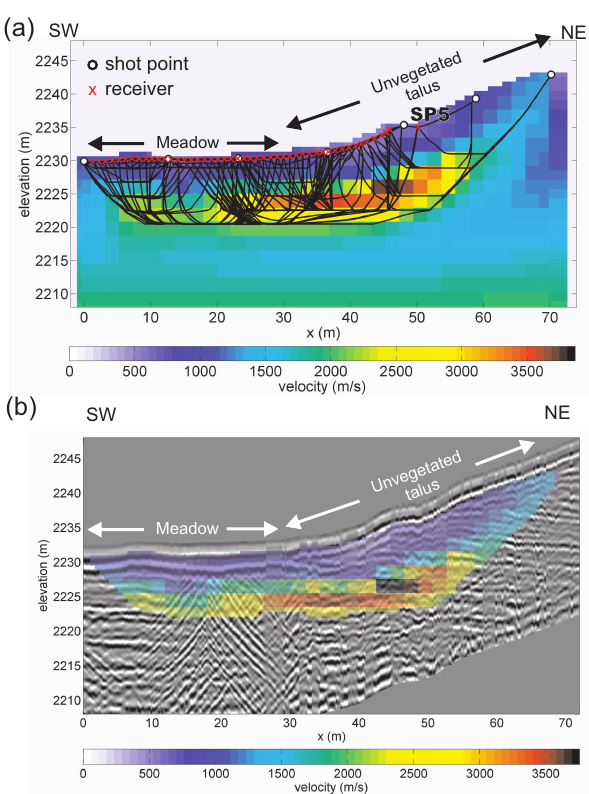
Fig. 8. (a) Inverted p-wave velocity tomogram for the seismic re- fraction profile (location shown in Fig. 3a). Shot-receiver raypaths calculated for the model are plotted as black lines. Shot gather data from shot point SP5 are shown in Fig. 7. (b) The same p-wave ve- locity tomogram as shown in (a) but plotted as a transparent overlay onto the corresponding cross-section for profile GPR1. Regions of the model that are not traversed by the raypaths shown in (a) are not